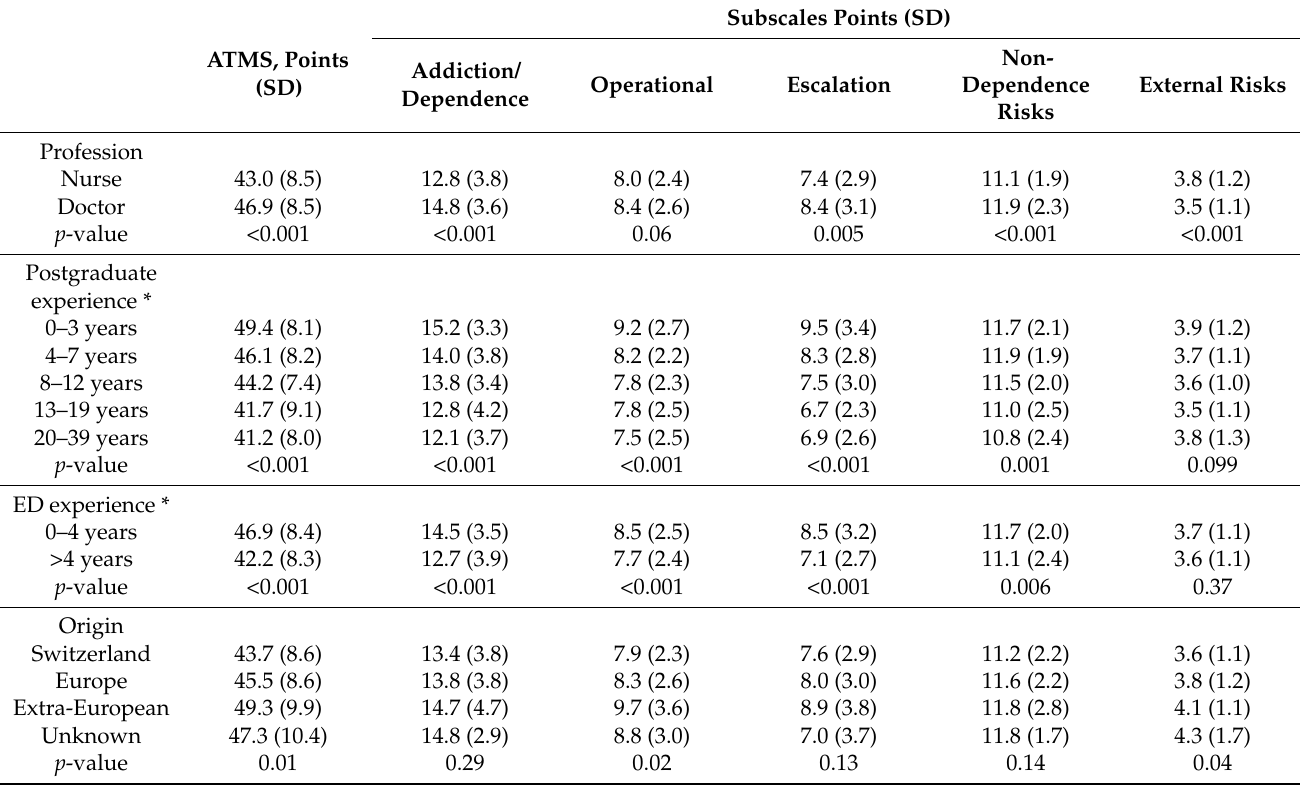
Table 2. Association between the Attitude towards Morphine Score (ATMS), its 5 subscales, and the healthcare providers’